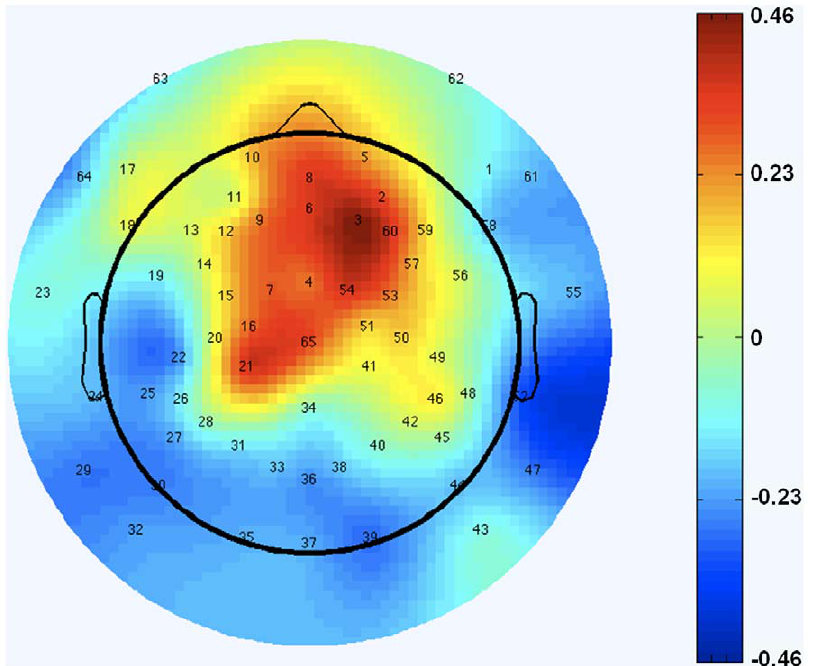
Figure 3. Predictive relation between early learning and 9-month neural activation of facial discrimination. Infants who learned more rapidly at one month of age showed greater discrimination in medial fronto-central activation to the mother’s versus a stranger’s face.